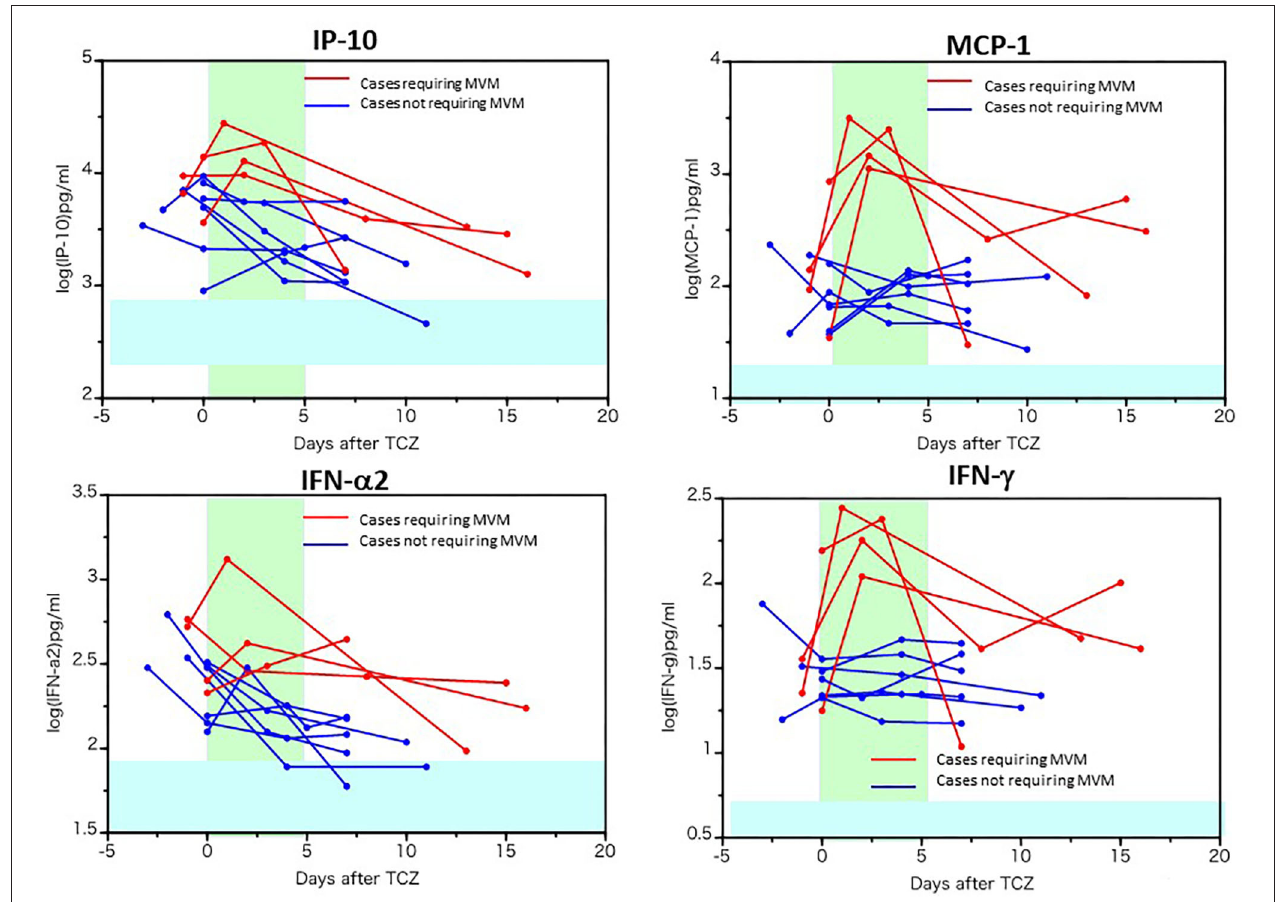
FIGURE 4 | Increased cytokines and chemokines in patients requiring mechanical ventilation before and after tocilizumab administration. The serum levels of IP-10, MCP-1, IFN- α 2 and γ in 10 patients with COVID-19 before and after tocilizumab injection were measured using a multiplex cytokine array system. The red line represents the data of patients requiring mechanical